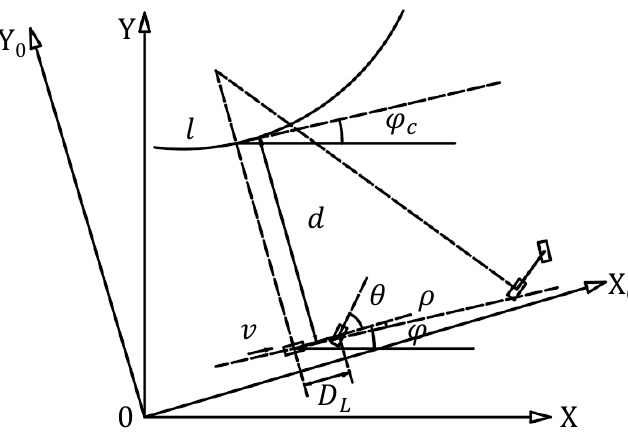
Figure 5. Construction diagram of the system.